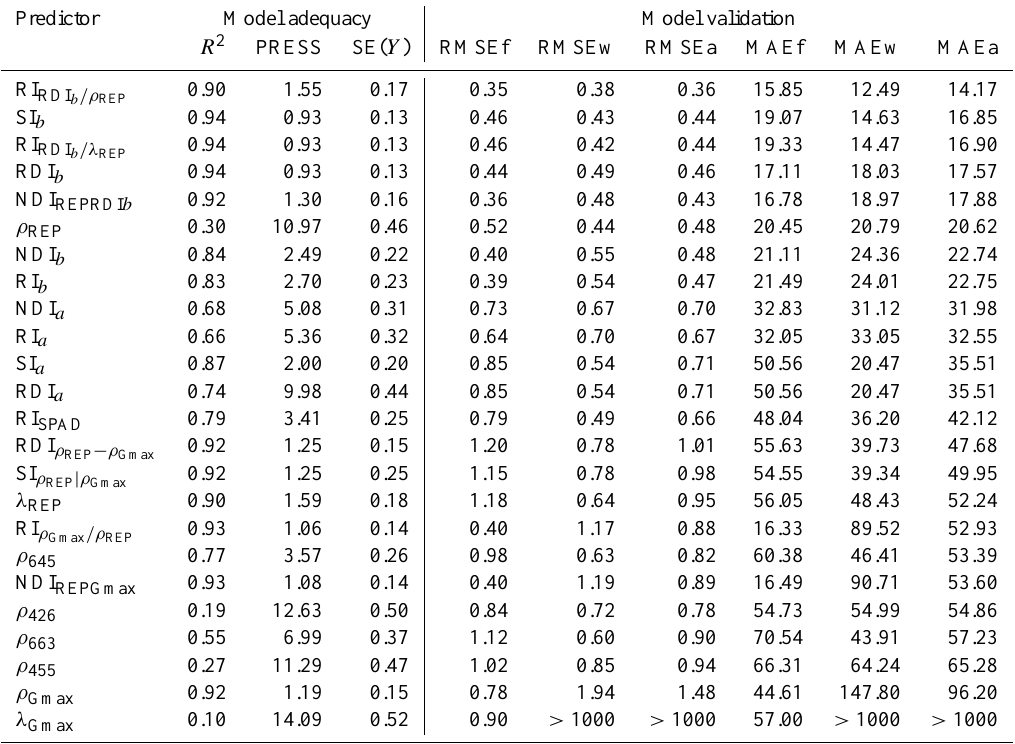
Table 3. Prediction accuracy assessment of the developed Chls empirical models.